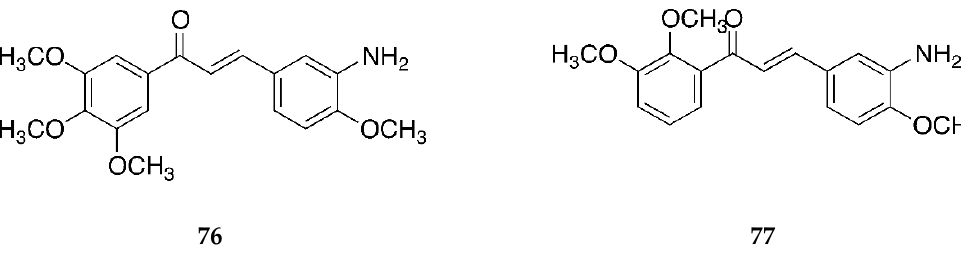
Figure 39. Chemical structures of 3′-aminochalcone derivative with methoxy substitutions on ring A and ring B.